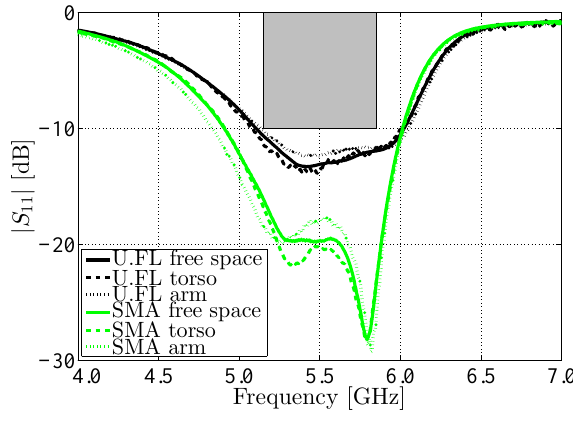
Figure 15. Magnitude of the reflection coefficient | S 1,1 | of the measured antennas in free space compared to measurement on torso and on the left arm, again with respect to a 50 Ω reference